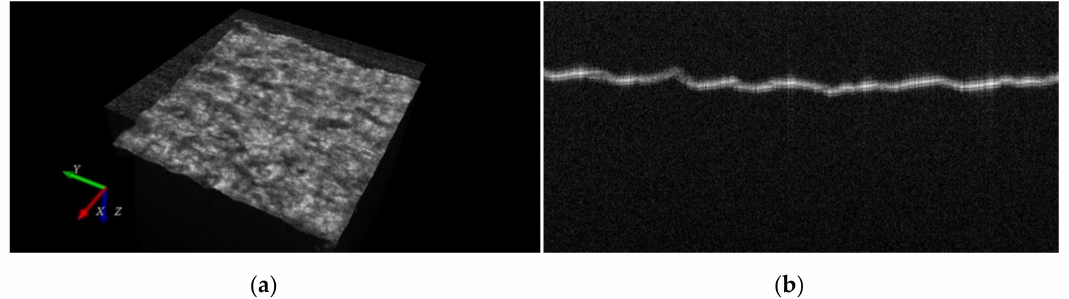
Figure 6. Examples of Cordura images with a silver layer scanned by OCT: ( a ) a perspective view; ( b ) a cross-section